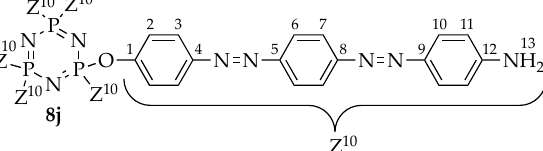
Figure 7. Structure of compound 8j with complete atomic numbering.